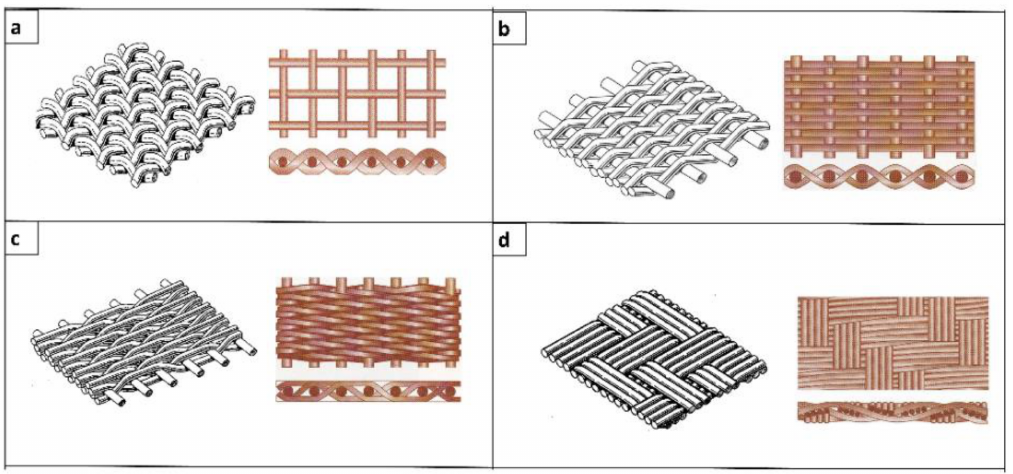
Figure 3. Woven fiber options: ( a ) Plain weave; ( b ) Plain Dutch weave; ( c ) Dutch Twill weave; ( d ) Stranded